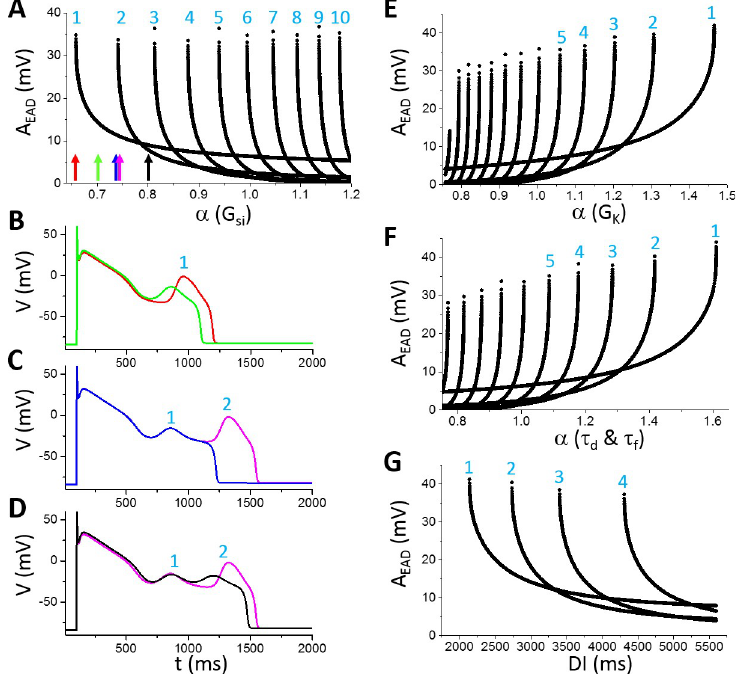
Fig 3. Dependence of EAD amplitude on ionic currents in the LR1 model. A . A EAD versus fold of control G si [labeled as α (G si )]. The colored arrows mark the α (G si ) values for the traces shown in B-D: red, α = 0.658; green, α = 0.7; blue, α = 0.74; magenta, α = 0.7425; and black, α = 0.8. The numbers mark the EAD order in an AP as indicated in B-D. For example, in B, there is only one EAD in both APs, then the EAD is labeled as the 1 st EAD. In C, a new EAD appears in the magenta AP, and this EAD is labelled the 2 nd EAD while the old one is labeled as the 1 st EAD. The number increases as more EADs appear in the AP. B . APs with one EAD as α indicated by the red and green arrows in A. C . APs in the transition from one EAD to two EADs as α indicated by the blue and magenta arrows in A. D . APs with two EADs as α indicated by the magenta and black arrows in A. E . A EAD versus fold of control G K . F . A EAD versus fold of control τ d and τ f . In these simulations, τ d and τ f are multiplied by the same α . G . A EAD versus DI. α (G si ) = 0.95 and other parameters are their control